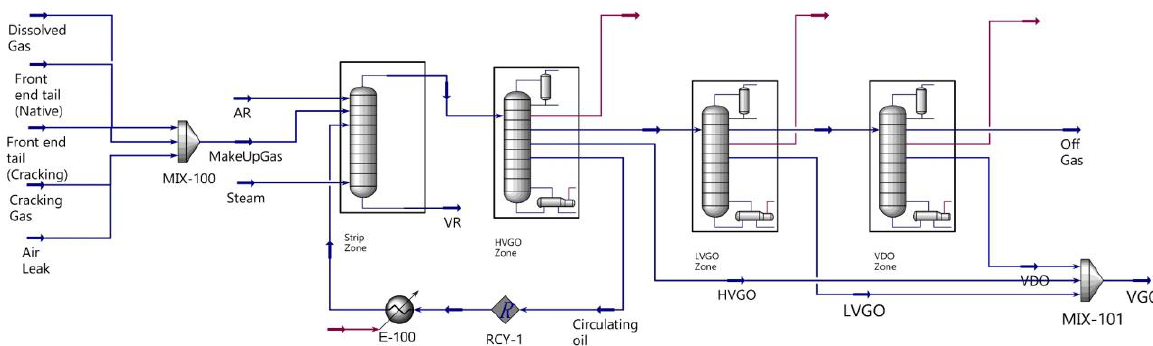
Figure 2. Simple model process flow diagram.